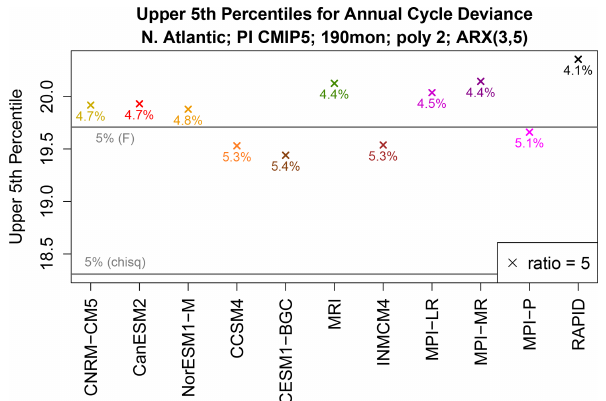
Figure C1. Upper 5th percentiles of the cycle deviance D (cid:127) for fitting ARX(3,5) models from 190-month time series when the noise variance ratio equals 5 (crosses). Percentiles are estimated by Monte Carlo techniques. For the two ARX(3,5) models being com- pared, the AR parameters and cycle parameters are the same and equal those estimated from each CMIP5 model on the x axis. The upper 5th percentiles of the appropriate chi-squared distribution and F distribution are indicated by horizontal grey lines. The colored numbers give the α of the F distribution corresponding to the point indicated by the